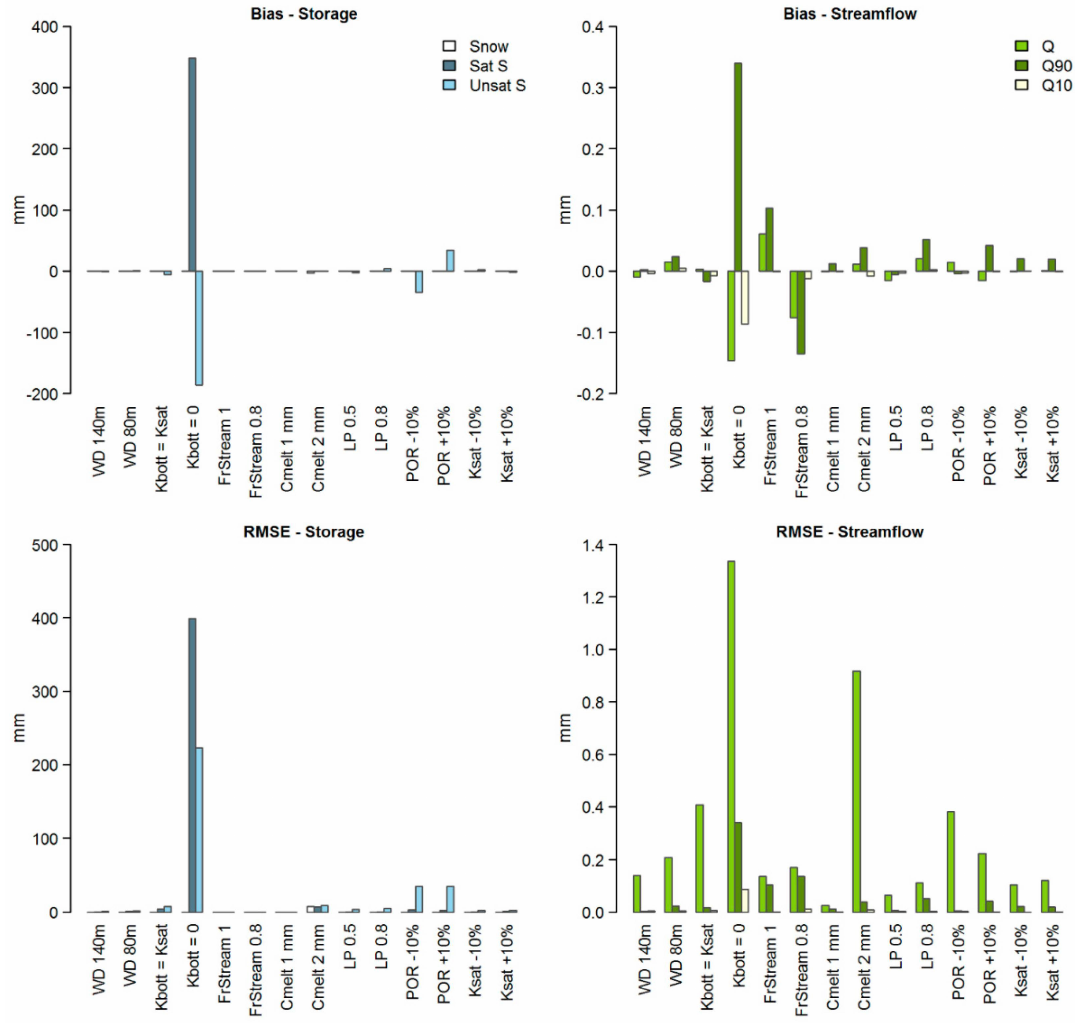
Figure 6. Change of water storage and streamflow components when parameters are varied compared to a baseline. The change is expressed in terms of Bias and